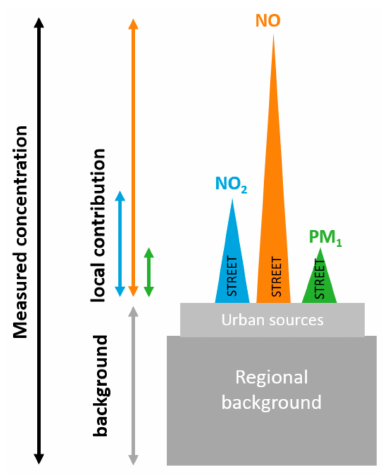
Figure 10. Urban air pollution buildup with contributions from background and local sources for NO 2 (blue), NO (orange) and PM 1